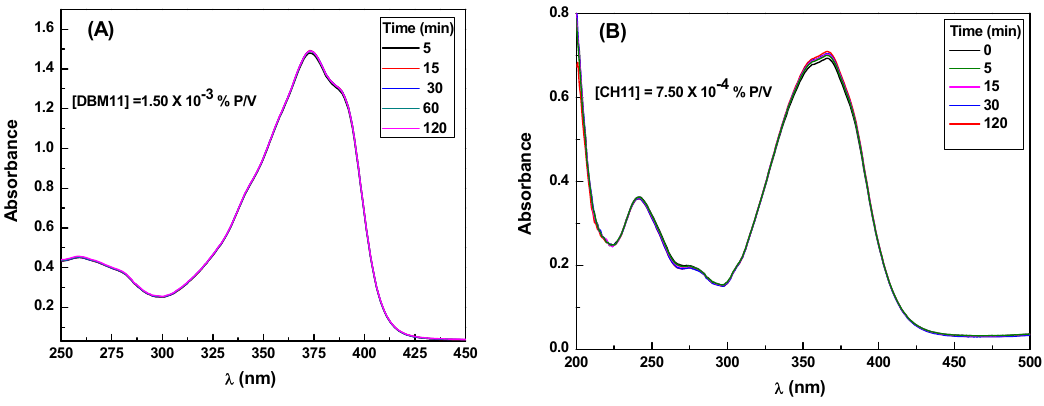
Figure 10. Photodecomposition of DBM11: ( A ) and CH11 ( B ) with 8.56 mW/cm 2 .